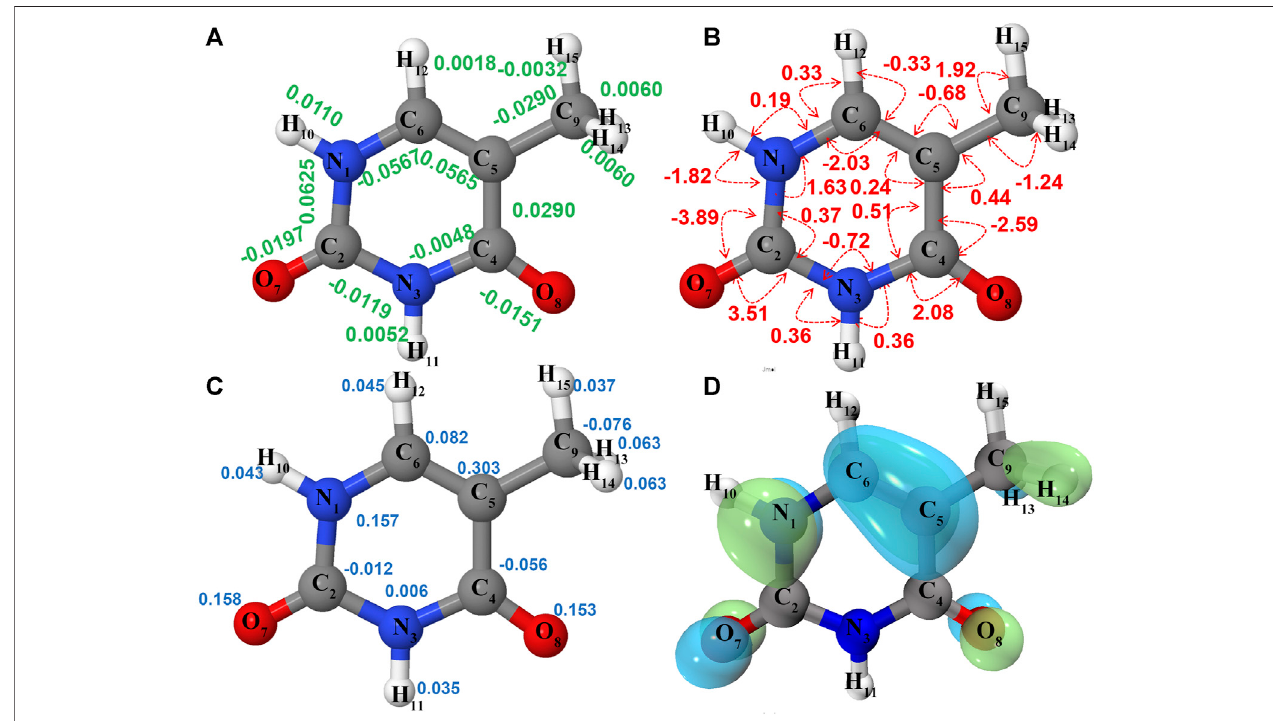
FIGURE 2 | Structure and properties of neutral thymine ( (cid:1) X 1 A ′ ) as computed at the B2PLYP/AVTZ level, along with the changes of speci fi c parameters between cationic( (cid:1) X 2 A ″ )andneutral( (cid:1) X 1 A ′ )thymine. (A) bondlengthchanges,green; (B) bondanglechanges,red; (C) chargechanges,blue; (D) HOMOorbitalofthymine(neutral) (cid:1) X 1 A ′ . (A) ∼ (D) numbering of the atoms constituting the thymine (neutral) molecule as used in the following